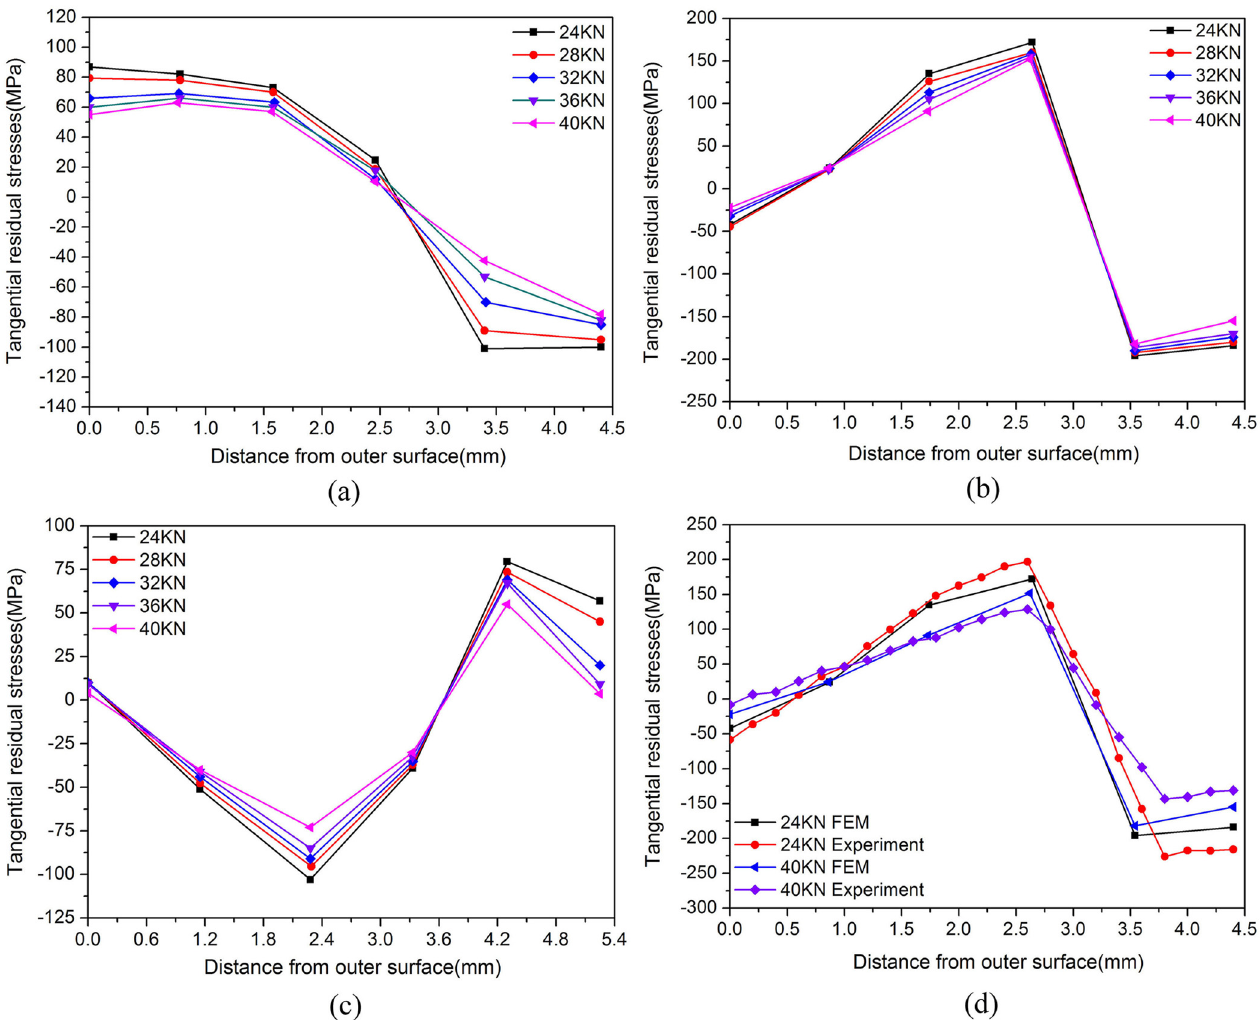
Fig. 8. Tangential residual stress distribution in the (a) cup bottom, (b) cup wall and (c) die entrance radius of square cups under various blank holder forces, and (d) comparison of the residual stresses in the cup wall obtained from numerical simulations and experimental